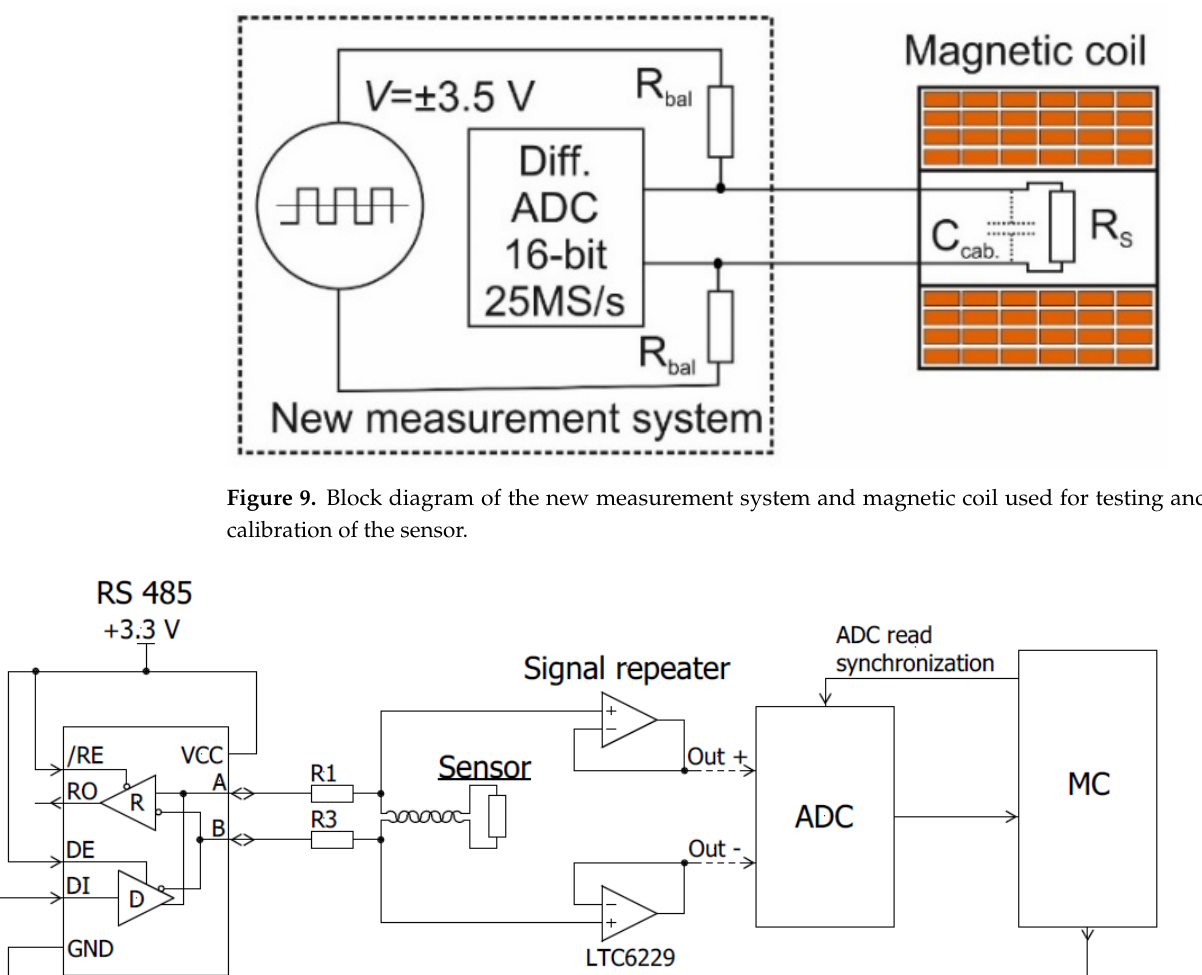
Figure 10. Circuit diagram of the sensor supply and digitalization of output signal.